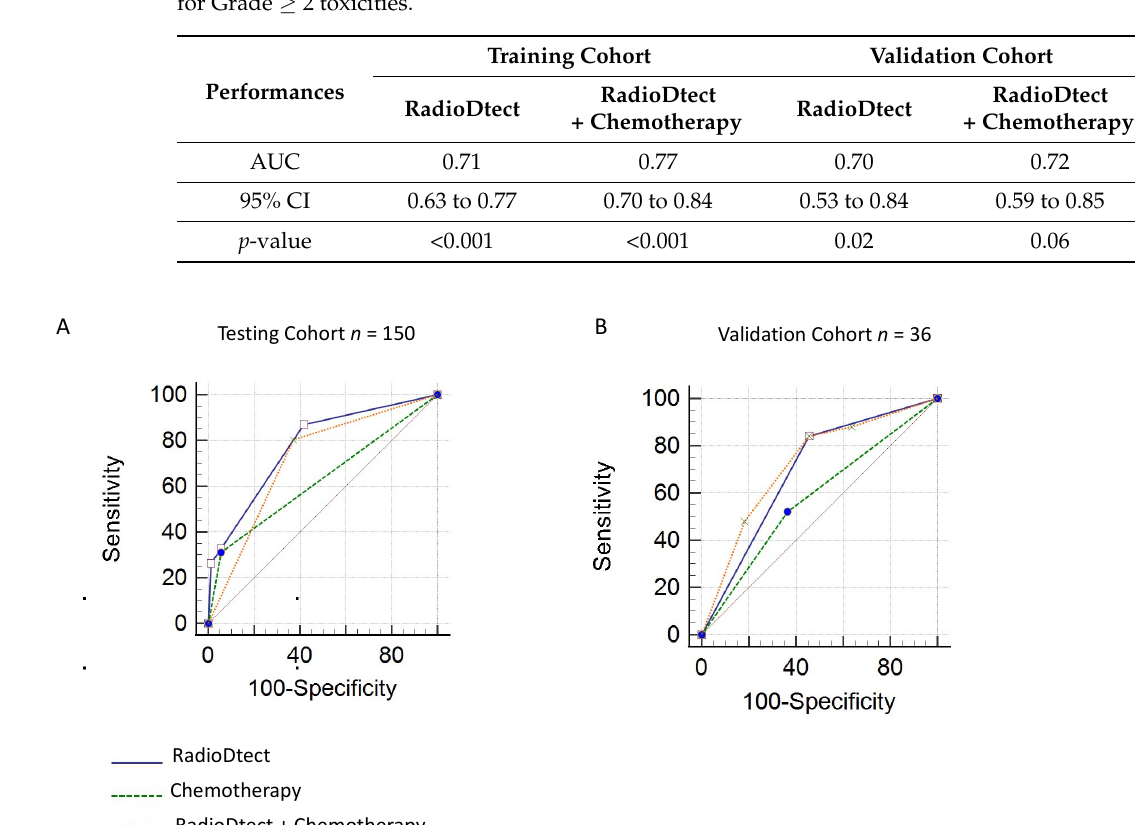
Figure 3. Performance analysis of combination of RadioDtect and chemotherapy as a binary variable for predicting grade ≥ 2 toxicities ( A ) ROC analysis for the testing cohort ( B ) ROC analysis for the validation cohort.